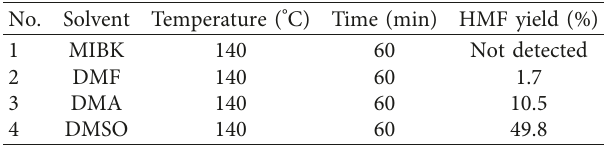
Table 1: Effect of different types of solvents on the acid-catalyzed dehydration of fructose to HMF a .